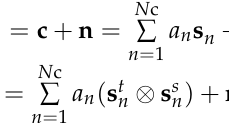
Figure 1. Platform geometry of airborne radar. Neglecting the effect of range ambiguity, a general model for the received data of the l th range gate x l ∈ MN × 1 can be expressed as: